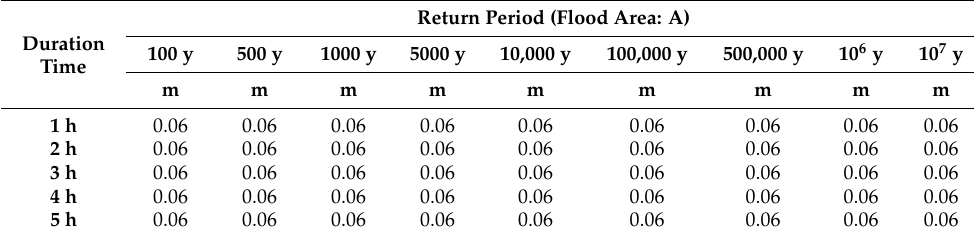
Figure 15. 2D flood depths from the 2D internal analysis results (Area C, NPP 4). Table 6. Maximum flood depth in the turbine building of NPP 2 (2D analysis result).